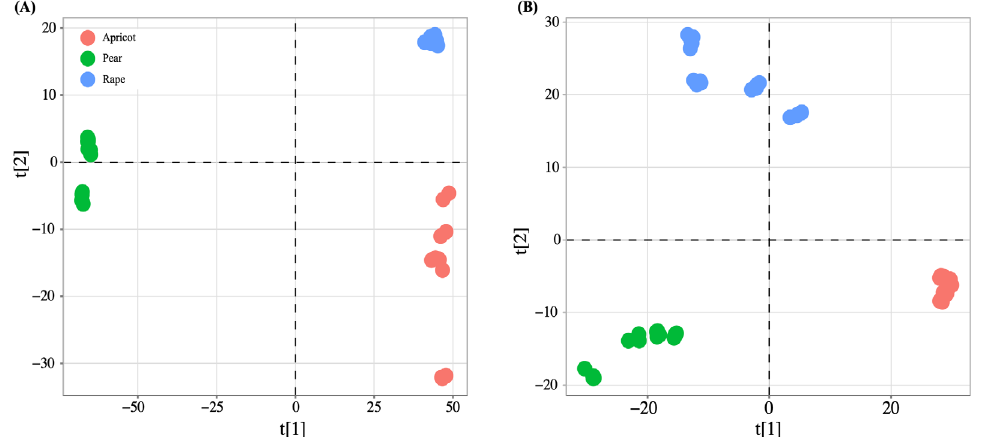
Figure 3. PLS-DA score plots from multivariate statistical analysis, t[1] and t[2] represent the first and second predictive principal components, respectively. ( A ) Score plots for hemolymph metabolites after 7 days of bee pollen feeding (number of apricot, rape, and pear samples: 13, 17, and 13, respectively). ( B ) Score plots for hemolymph metabolites after 14 days of pollen feeding (number of apricot, rape, and pear samples: 17, 18, and 17, respectively).